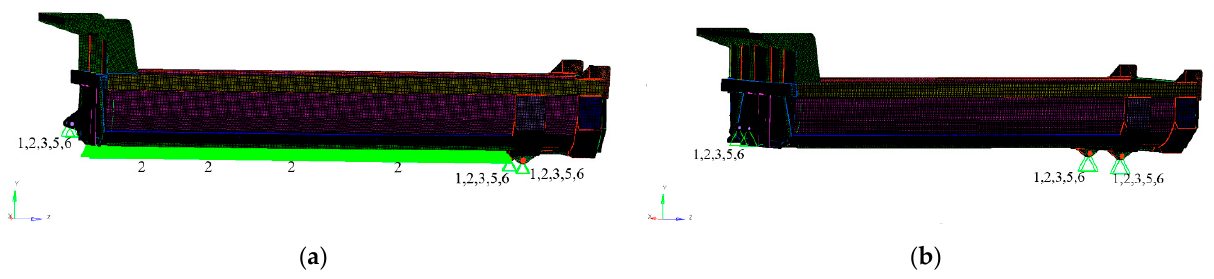
Figure 5. Constraint condition of U-carriage: ( a ) Full load case; ( b ) Lifting load case. The dump truck carriage is usually for storing loose material. In this paper, the load of sandy loam soil applied on the plates of the carriage is calculated according to Rankine’s theory of active earth pressure [34]. The pressure of sandy loam soil exerted on the floor, front, rear and side plates are shown in Figure 6.